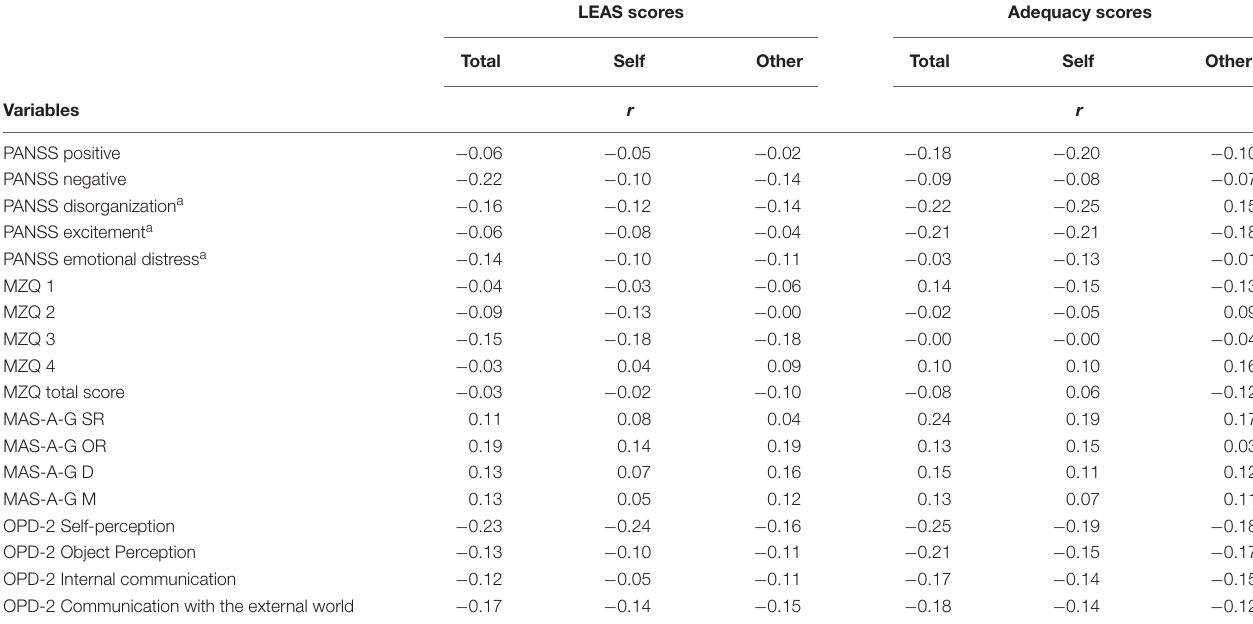
TABLE 4 | Results of the correlation analysis (Spearman correlation